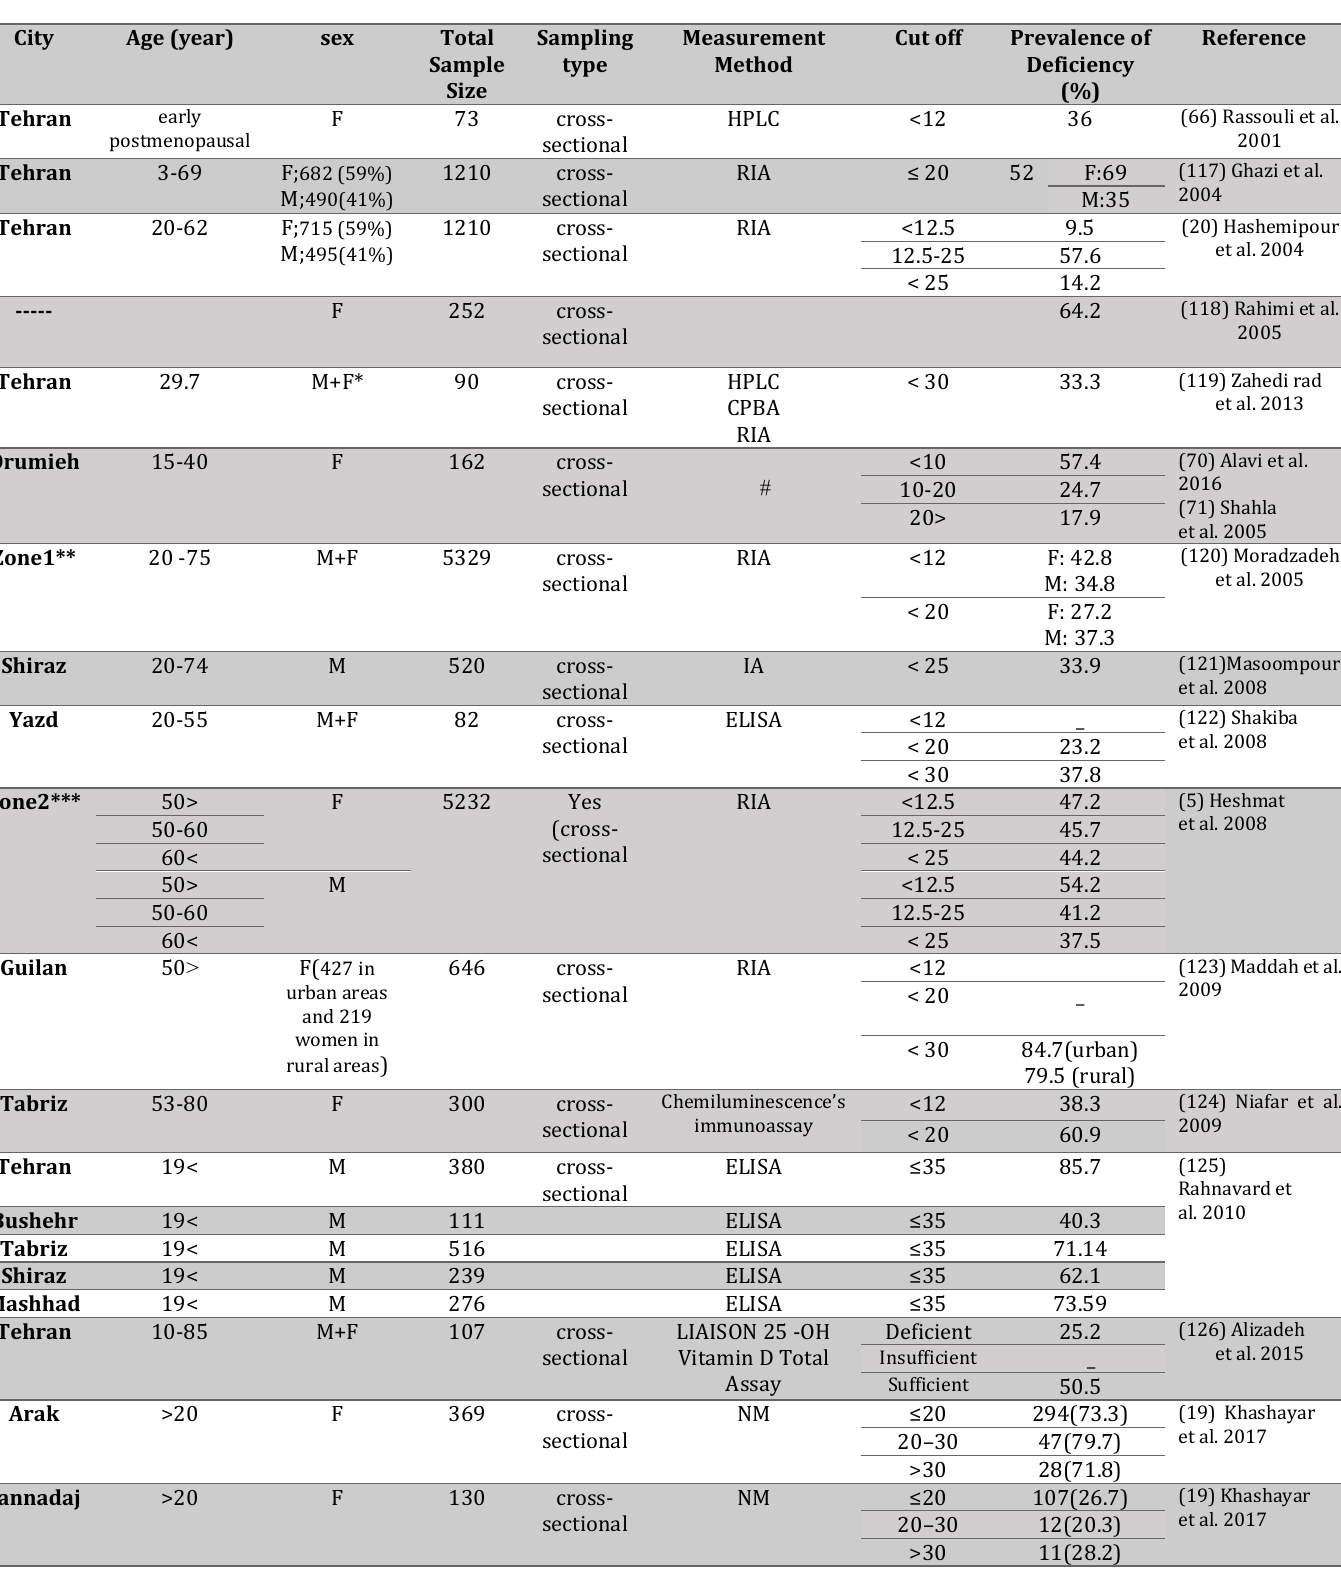
Table 4. Characteristic and main results for the prevalence of vitamin D deficiency or insufficiency in Iranian children, adolescents, adults and